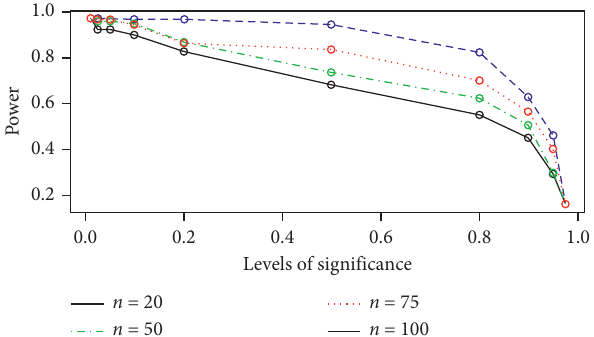
Figure 2: Power results at k � 2 with parameters (0.9, 0.1, 0.35, 5.0).